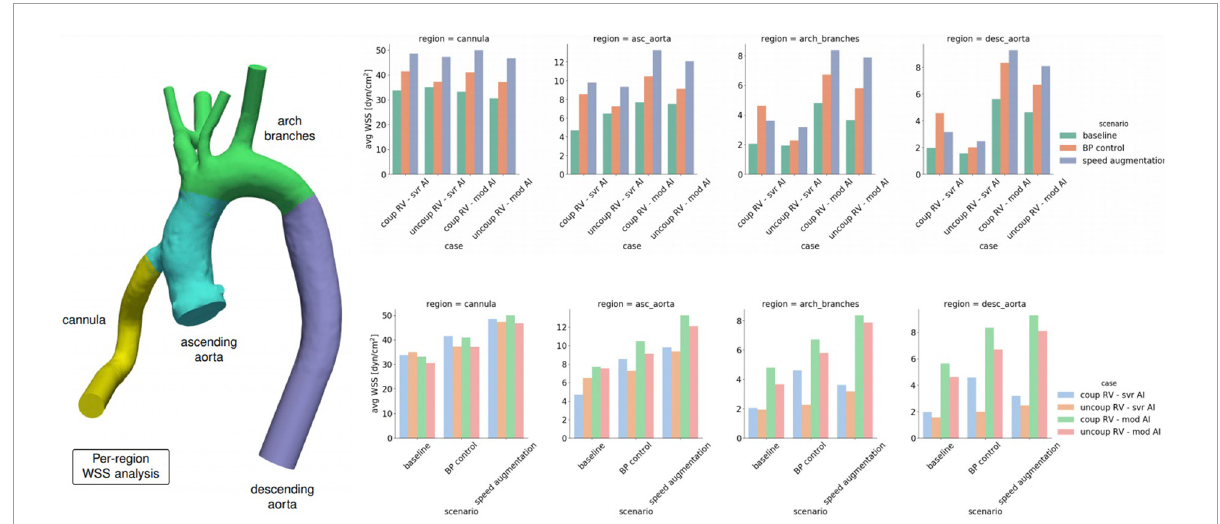
FIGURE2 Average wall shear stress (WSS) by location within the left ventricular assist device (LVAD) outflow cannula or aorta stratified by degree of right ventricular (RV) coupling, aortic insufficiency (AI) severity and medical and device management.